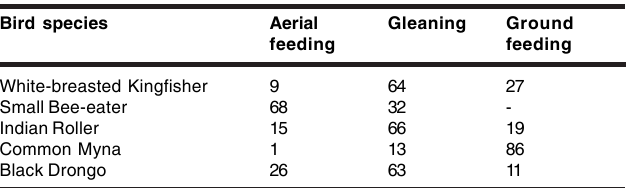
Table 4. Percentage use of various foraging methods by insectivorous birds Bird